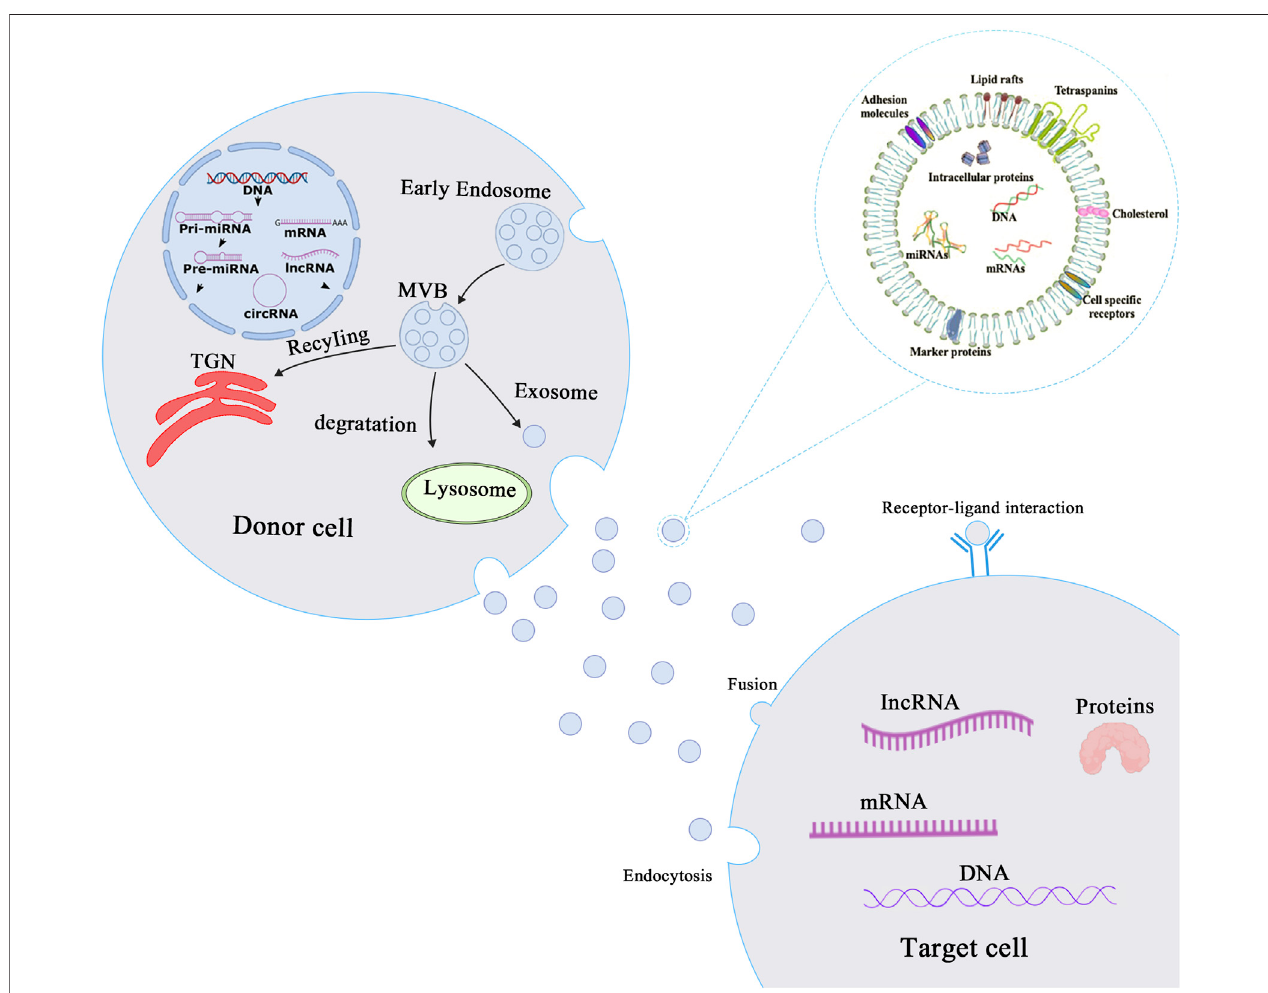
FIGURE 1 | Biogenesis and mechanisms of action of exosomes. Biogenesis and mechanism of action of exosomes. The process of exosome production starts withtheinvaginationofthecell membranetoform earlyendosomes,which bud inward toform intracellular multivesicular bodies (MVBs), and fi nallytheoutermembrane of MVB fuses with the cell membrane to release exosomes into the extracellular matrix. Exosomes then play a role in mediating intercellular communication through endocytosis, fusion or receptor-ligand interaction mechanisms.